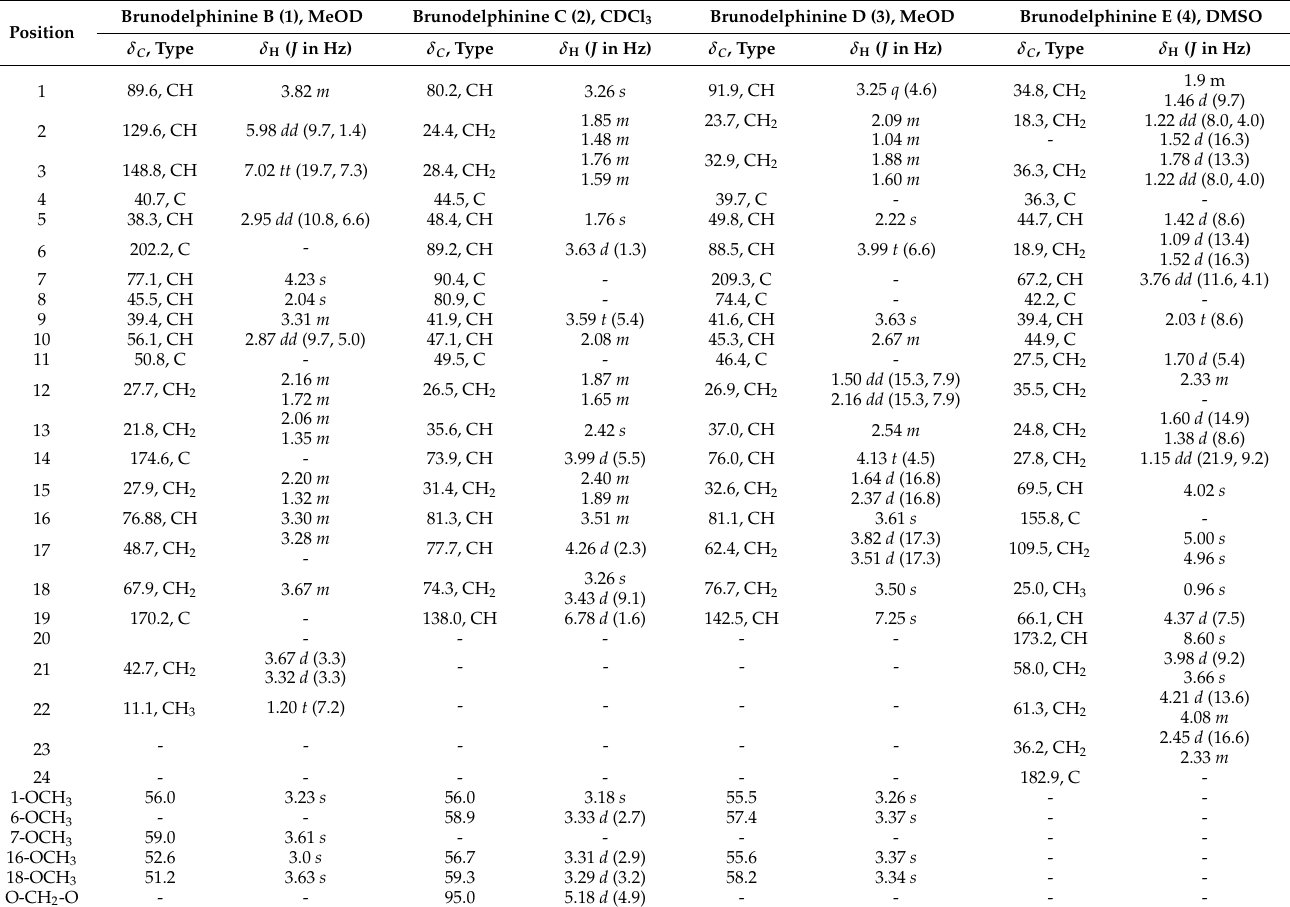
Table 1. NMR spectroscopic data of brunodelphinine B–E ( 1 – 4) (400 MHz for 1 H-NMR and 100 MHz for 13